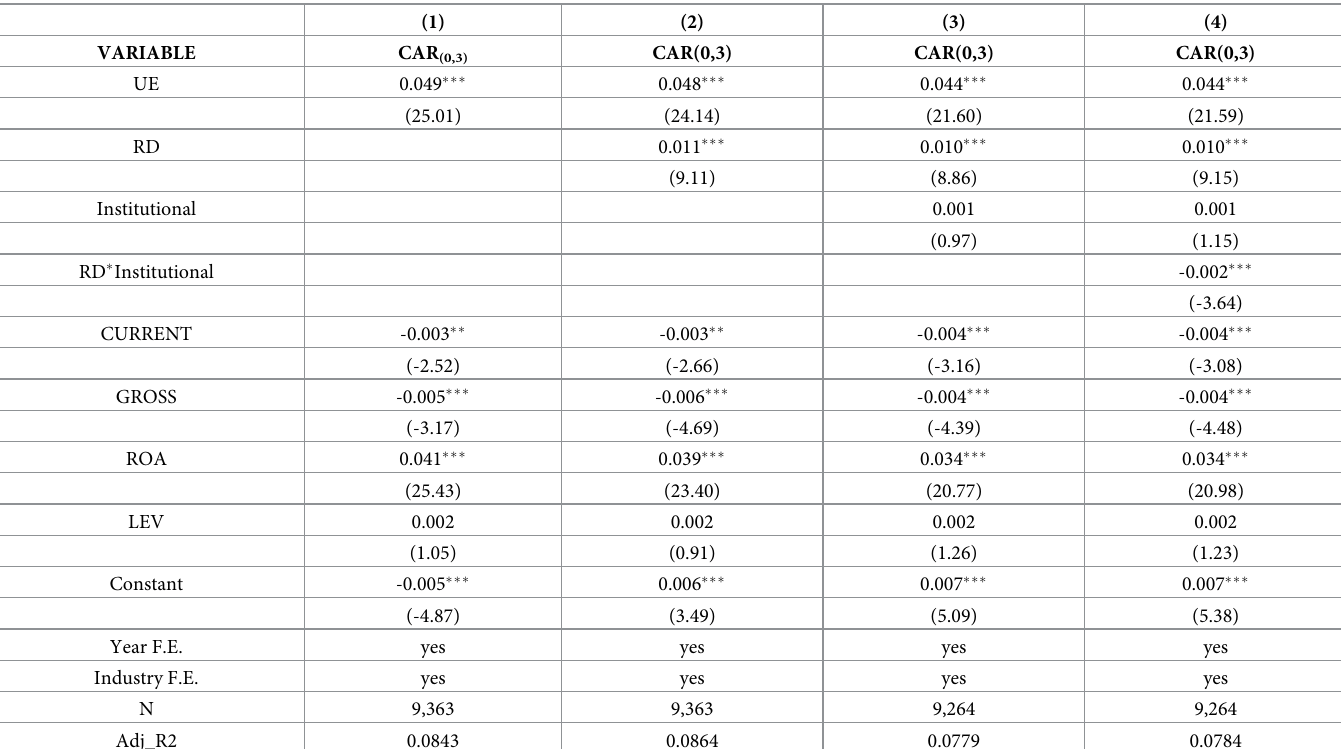
Table 3. Baseline regression